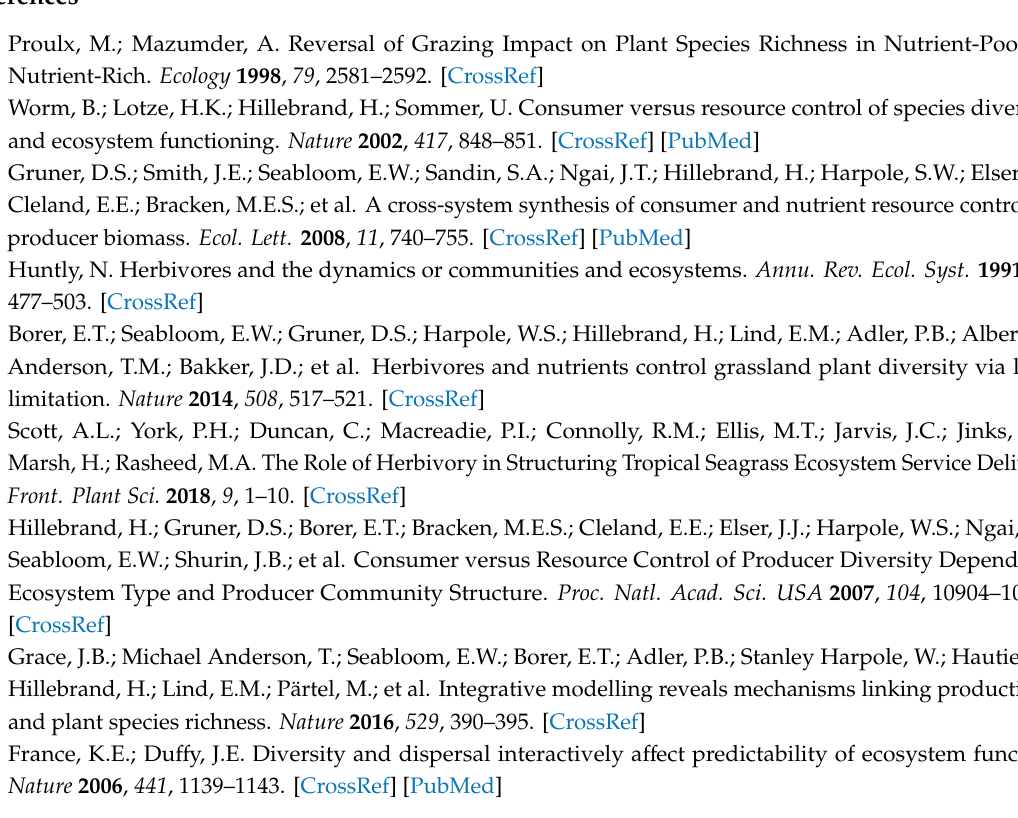
Predictor variables were z-transformed for direct comparison between regression